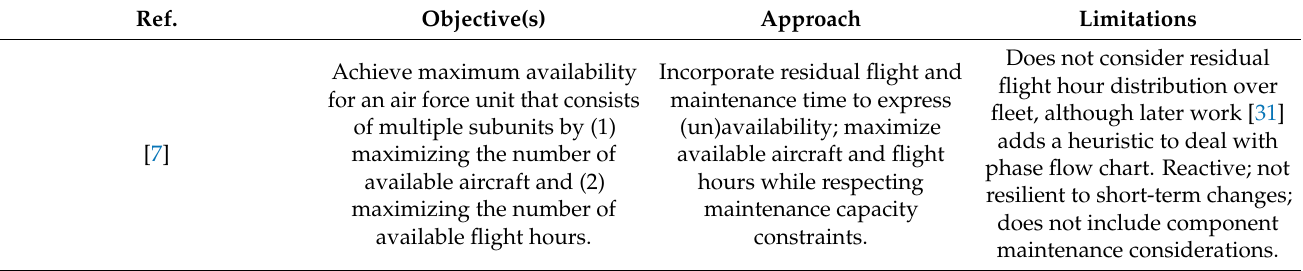
Table 1. Brief overview of objective(s) of, approaches to, and limitations of existing models for FMP optimization in defense aviation. Adapted from